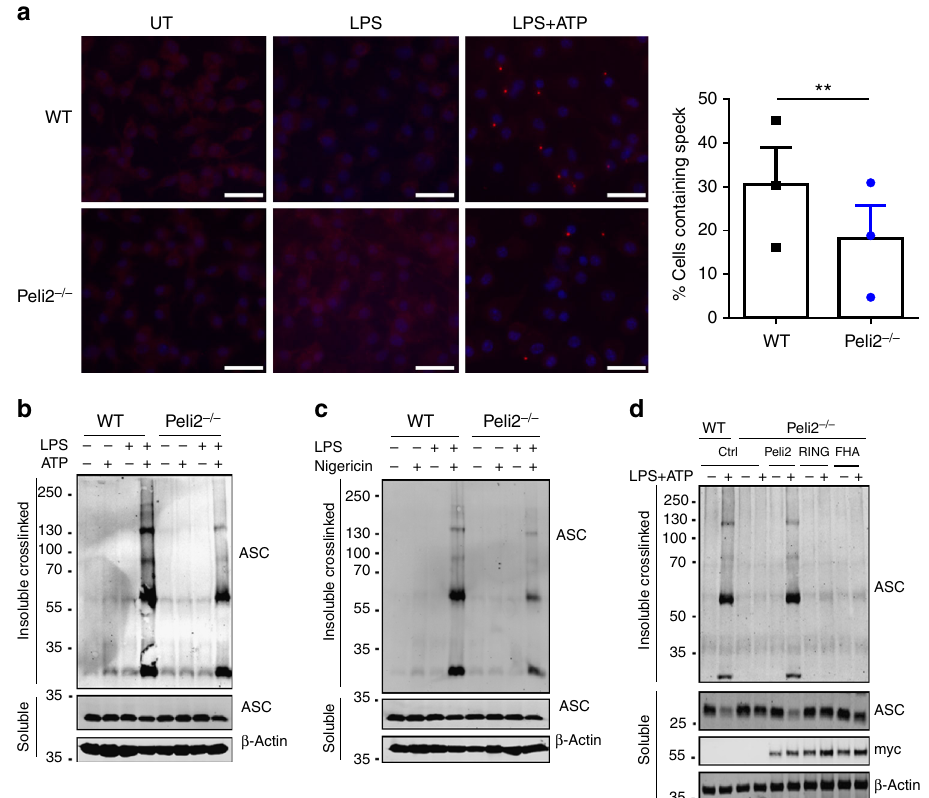
Fig. 6 Pellino2 mediates NLRP3-dependent oligomerization of ASC. a Immuno fl uorescence staining of ASC in WT and Peli2 − / − BMDMs that were left untreated (UT) or treated with 100 ng/ml LPS for 3 h and further stimulated with ATP for 30 min. ASC specks were detected by immunostaining using anti-ASC antibody and anti-rabbit Alexa Fluor 568 (red) and cells were counter stained with nuclei-staining DAPI. The histogram quantitates the percentage of cells that exhibit ASC speck formation. (scale bar = 100 μ m). b, c Immunoblot analysis of ASC in chemically cross-linked NP-40 insoluble fractions and in NP-40 soluble fractions from cell lysates of WT and Peli2 − / − BMDMs stimulated with 100 ng/ml LPS for 3 h with or without further treatment with b 2.5 mM ATP, or c 5 mM Nigericin for 30 min. β -Actin was used as loading controls. d WT and Peli2 − / − BMDMs were infected with MSCV as control (Ctrl) or with MSCV containing an expression construct encoding myc-tagged murine Pellino2 (Peli2), Pellino2 RING mutant (RING), or Pellino2 FHA mutant (FHA). Immunoblot analysis of ASC in chemically cross-linked NP-40 insoluble fractions and in NP-40 soluble fractions from cell lysates of MSCV-infected cells treated with 100 ng/ml LPS for 3 h followed by 2.5 mM ATP for 30 min. The expression of the Pellino2 constructs was measured by immunoblotting with an anti-myc antibody. ** p < 0.01 (paired, two-tailed Student ’ s t -test). Data are the mean ± s.e.m. of three independent experiments ( a , right panel) or biological replicates that are representative of three independent experiments ( a left panel, b, c, d